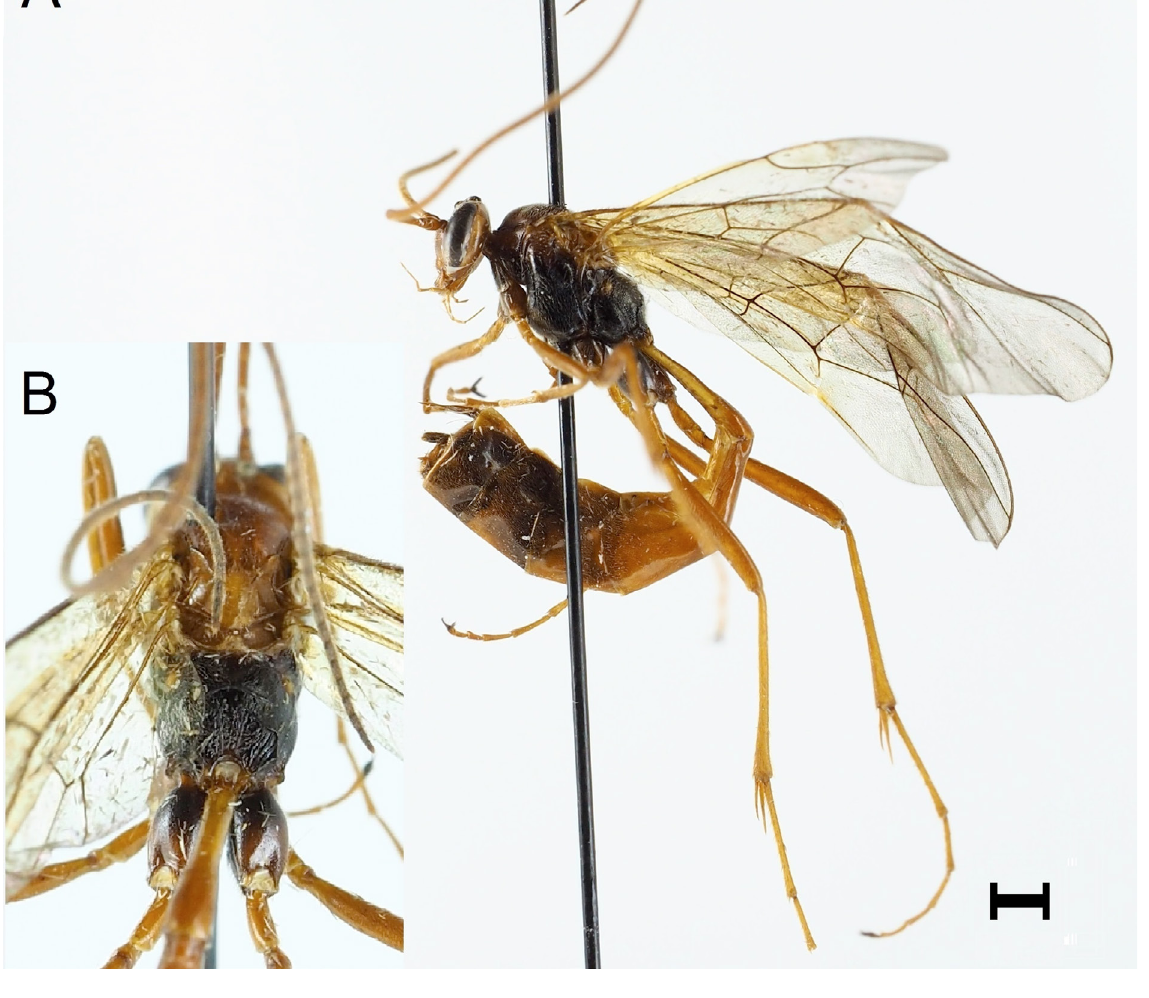
Fig. 45. Ophion vardali Johansson sp. nov., paratype, ♀ (NHRS-HEVA000008748). A . habitus, lateral view. B . Mesosoma, postero-dorsal view. Scale bar: A = 1